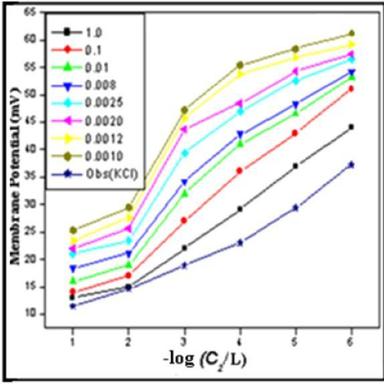
Plots of membrane potential (theoretical and observed) against logarithm of concentration of KCl electrolyte solution for PVC–NP composite membrane.